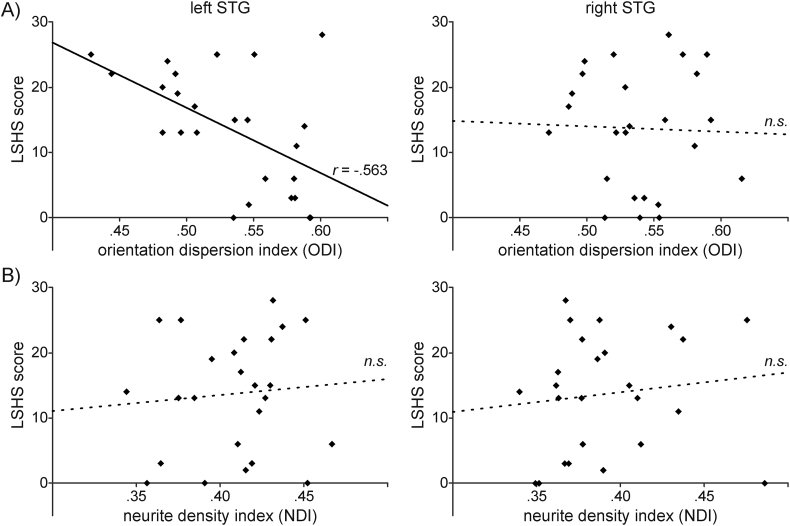
Relationship between NODDI-based measures of microstructure and hallucination proneness. The scatter plots show scores of hallucination proneness (LSHS) as a function of A) orientation dispersion (ODI) and B) neurite density (NDI) of the left and right superior temporal gyrus (STG), respectively. ODI values (but not NDI) in the left STG (but not the right STG) showed a significant correlation with LSHS scores. Relationships that were significant (p < .05) in the multiple regression (see text) are indicated by sold lines and the partial correlation coefficient (r), non-significant (n.s.) by dashed regression lines. n = 25.